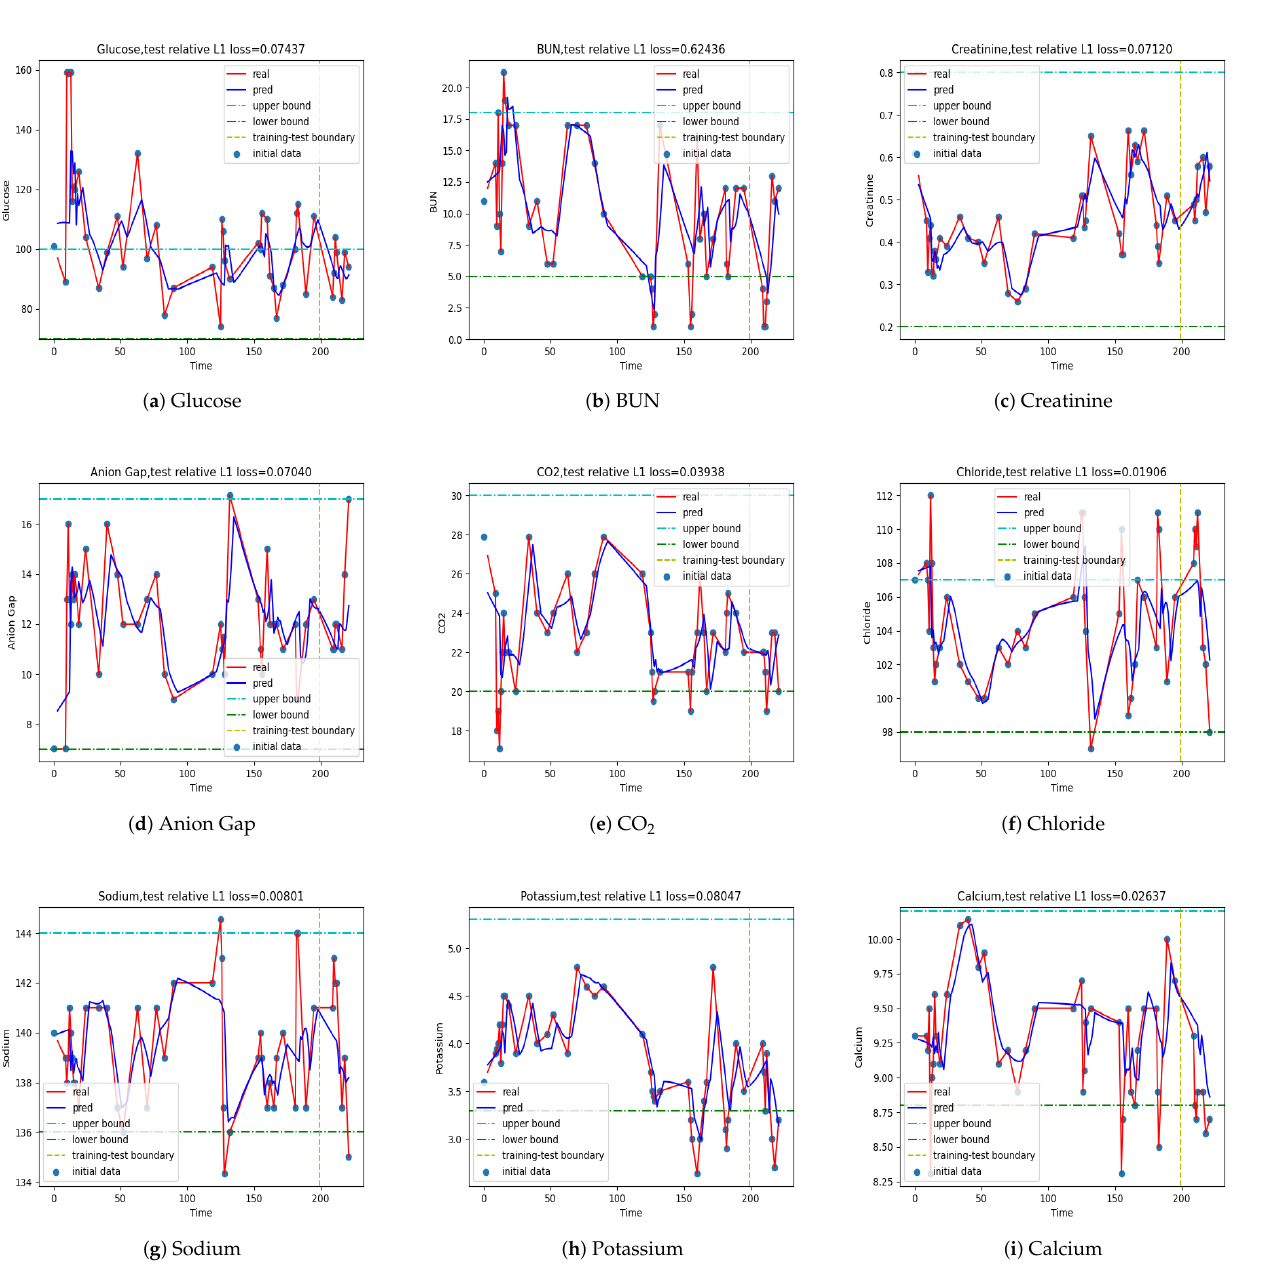
Figure 9. Multistep predictions of the LSTM model for patient MS at T = 1, L =